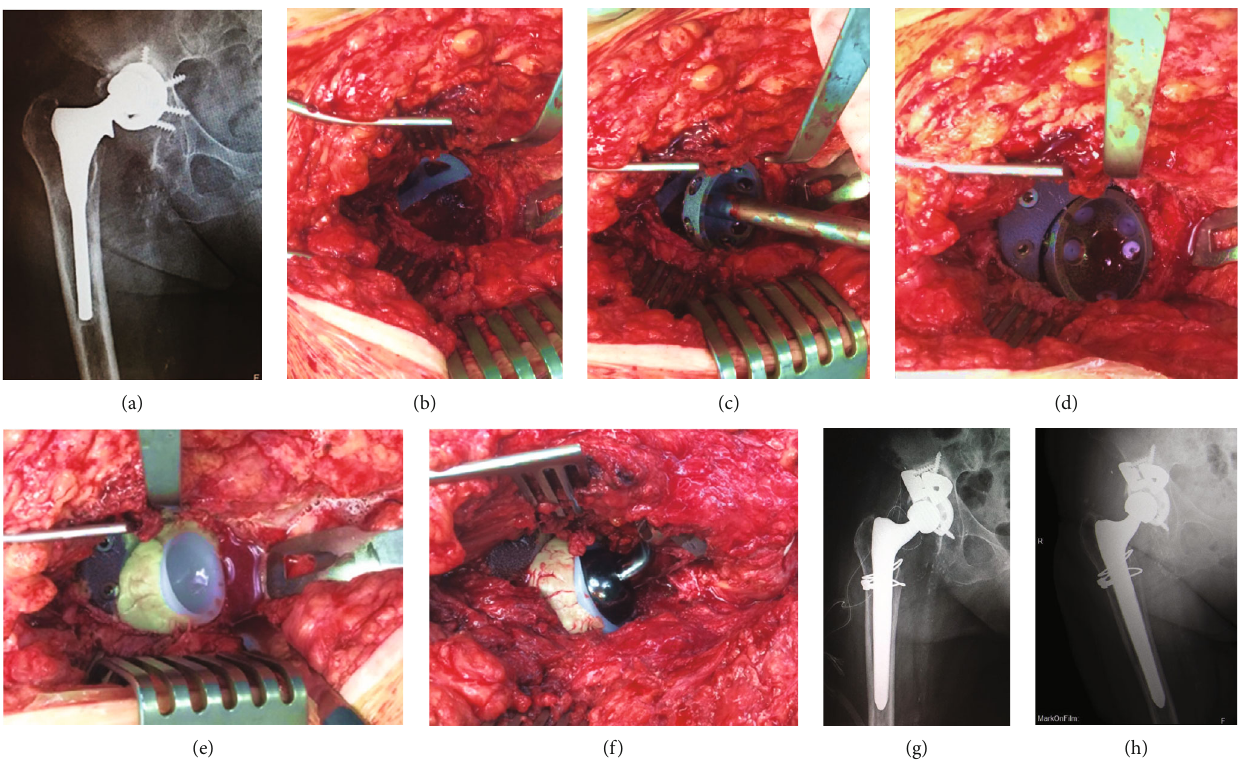
Figure 1: (a) Preoperative X-ray. (b) “ Footing ” type augment at the cavitary defect. (c) Cup insertion. (d) Cup-augment construct. (e) Polyethylene insertion. (f) Intraoperative image after reduction of the hip. (g) Postoperative X-ray. (h) 5y